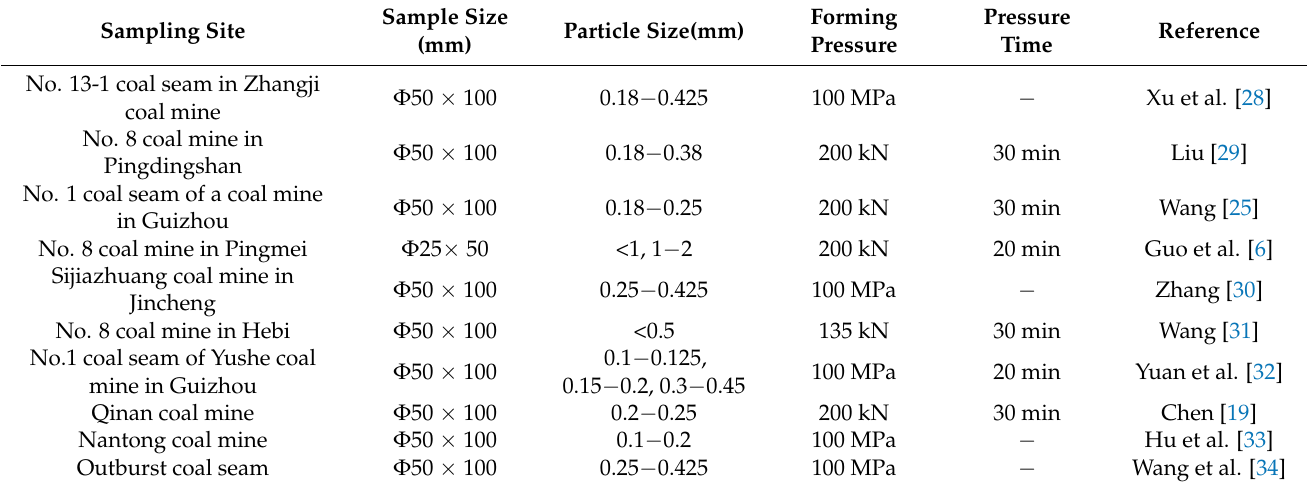
Table 1. Preparation methods of RTC samples from Chinese coal